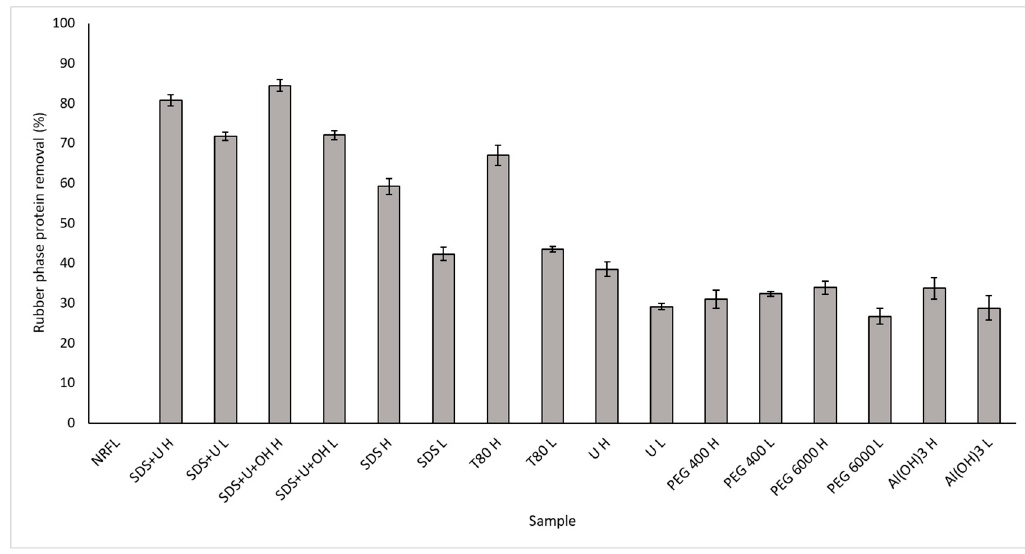
Figure 6. Deproteination systems.